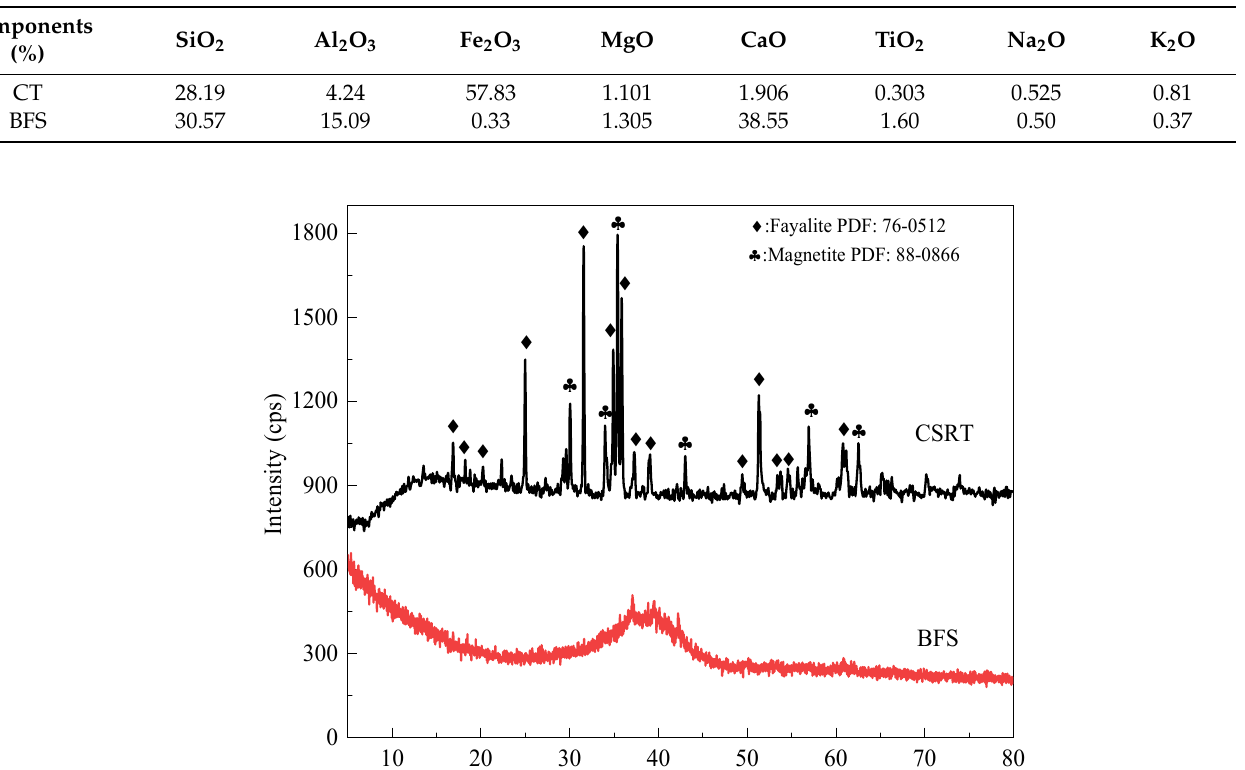
Table 1. Chemical composition of the CT and BFS.